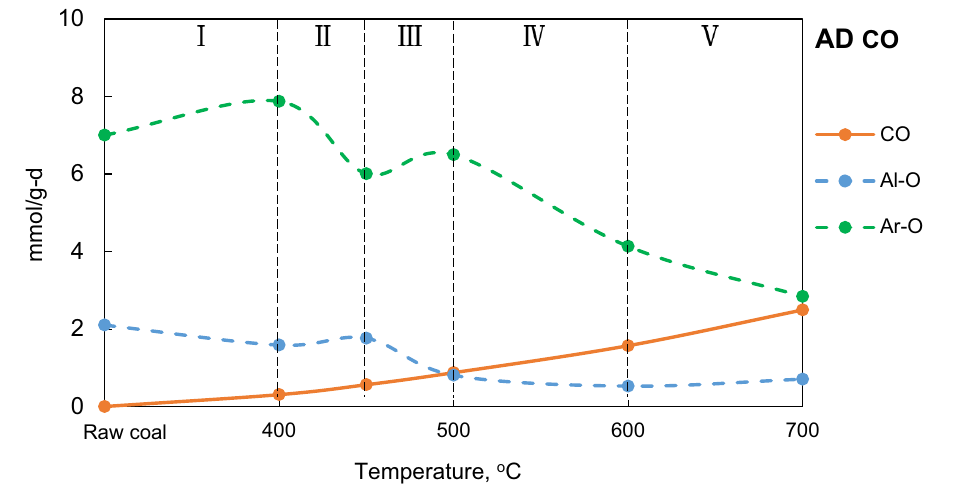
Fig. 3 Integration of CO as a function of temperature and the trends of its relevant functional groups of Al–O and Ar–O of